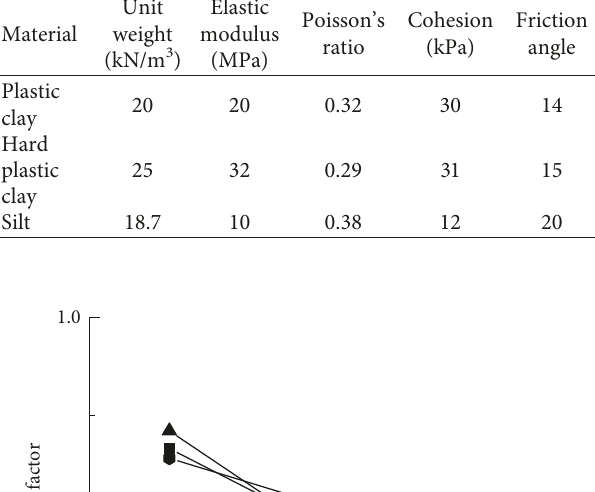
Figure 10: Variation of soil judgement factor at large ratio.